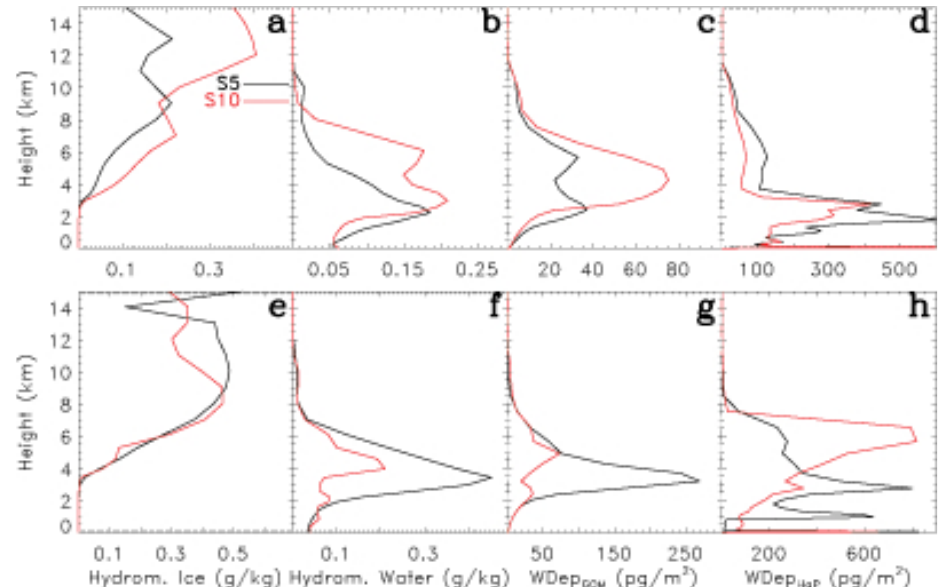
Fig. 9. Vertical average profiles of hydrometeors and scavenging in thunderstorms. (a) frozen hydrometeors; (b) rain (liquid hydrometeors); (c) net scavenging of GOM; (d) net scavenging of HgP. Category s5 is in black and s10 in red. CAPE is in c2500 for all simulations. Panels (a) – (d) are PW category p50. Panels (e) – (h) are PW category p60. Note the change of scale between the top and bottom